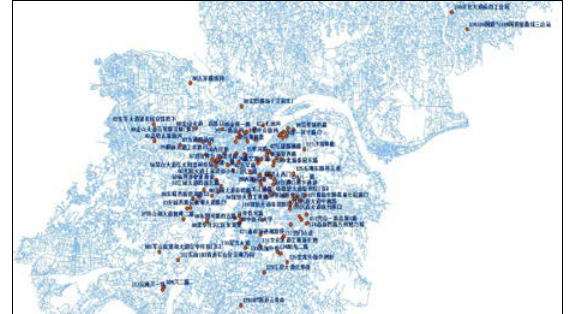
Figure 3. Distribution of sample waterlogging points Table 3. Input data of samples Number